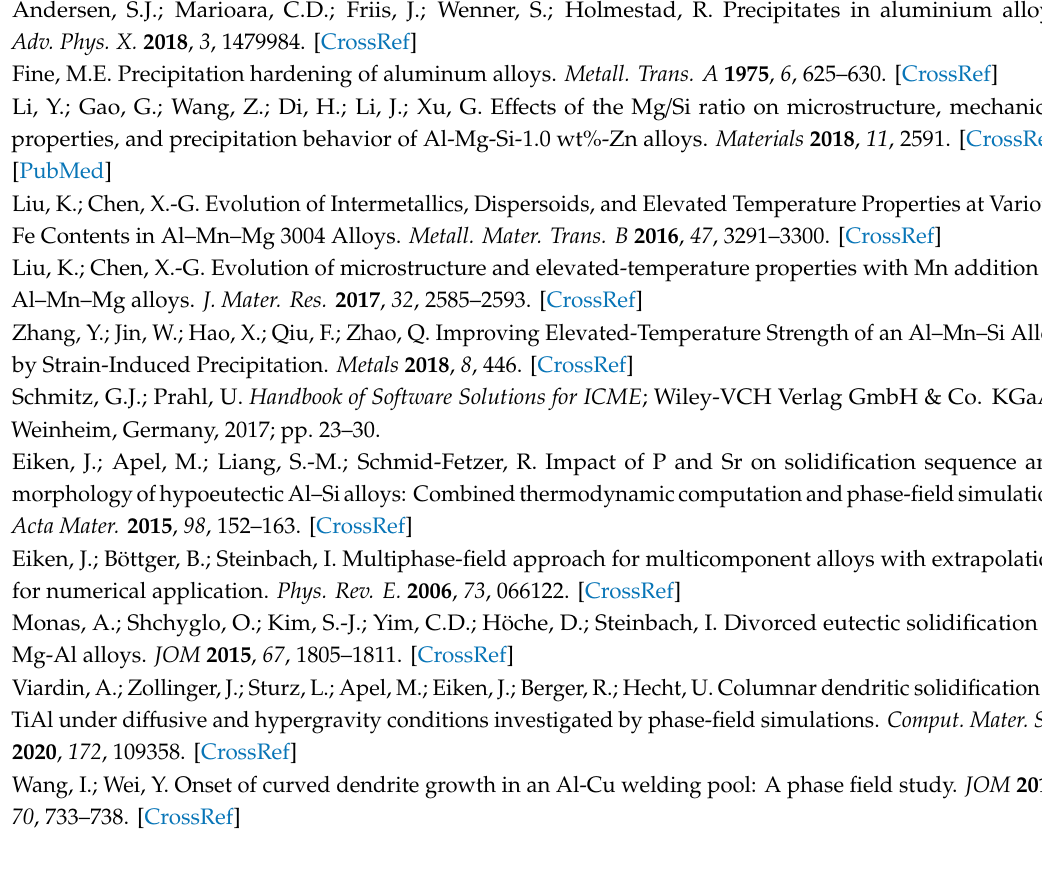
Figure S1: Construction design details of the casting mold, Figure S2: Simulation scheme, Figure S3: Precipitate size distribution at the end of simulation (t = 11.2 s, T = 920